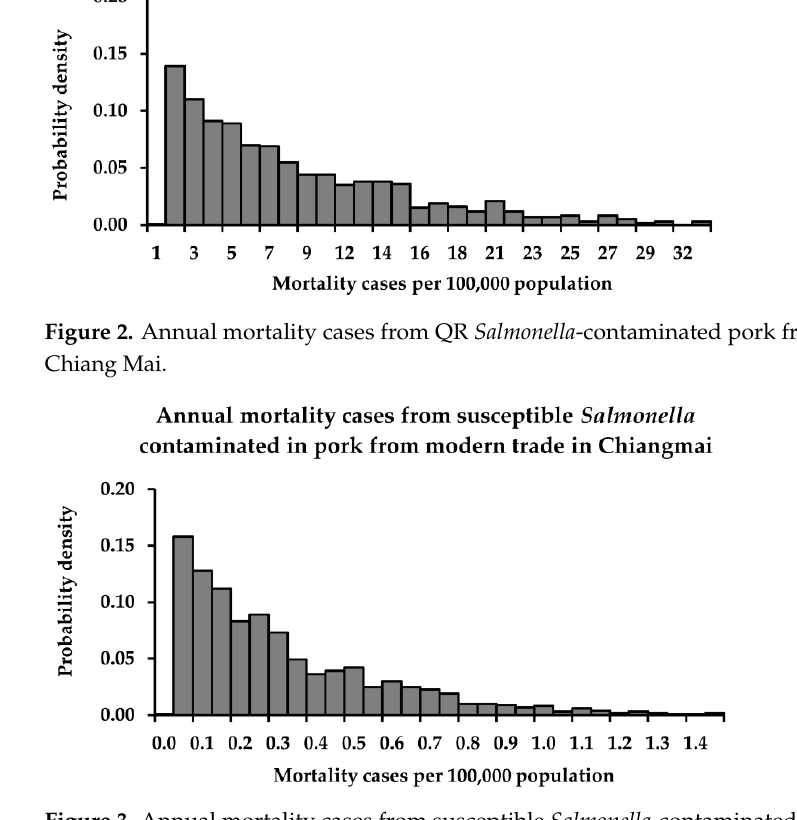
Figure 3. Annual mortality cases from susceptible Salmonella -contaminated pork from the modern trade in Chiang Mai.